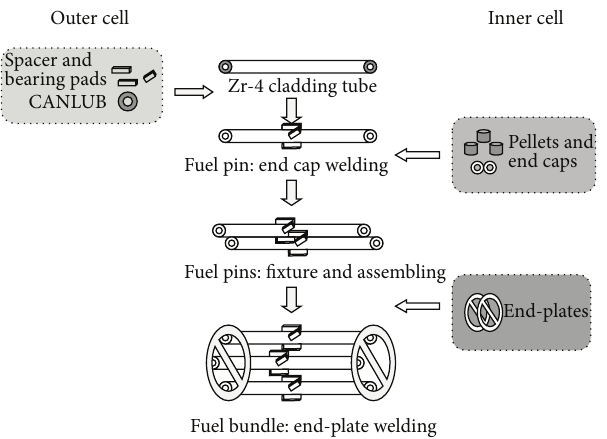
Figure 2: Process of end-plate welding operation and